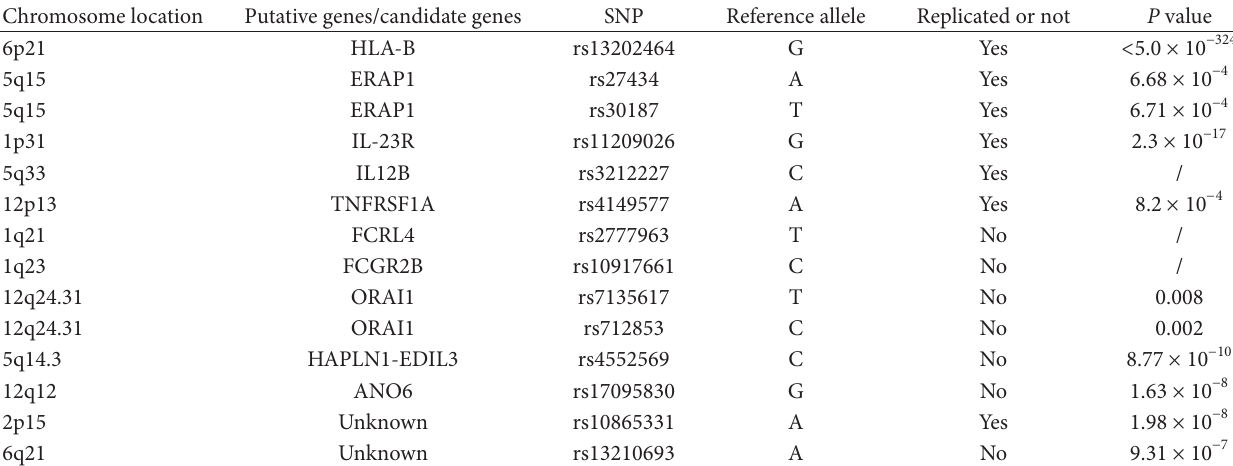
T 1: Genes/gene regions de�nitely associated with AS in Chinese population. Chromosome